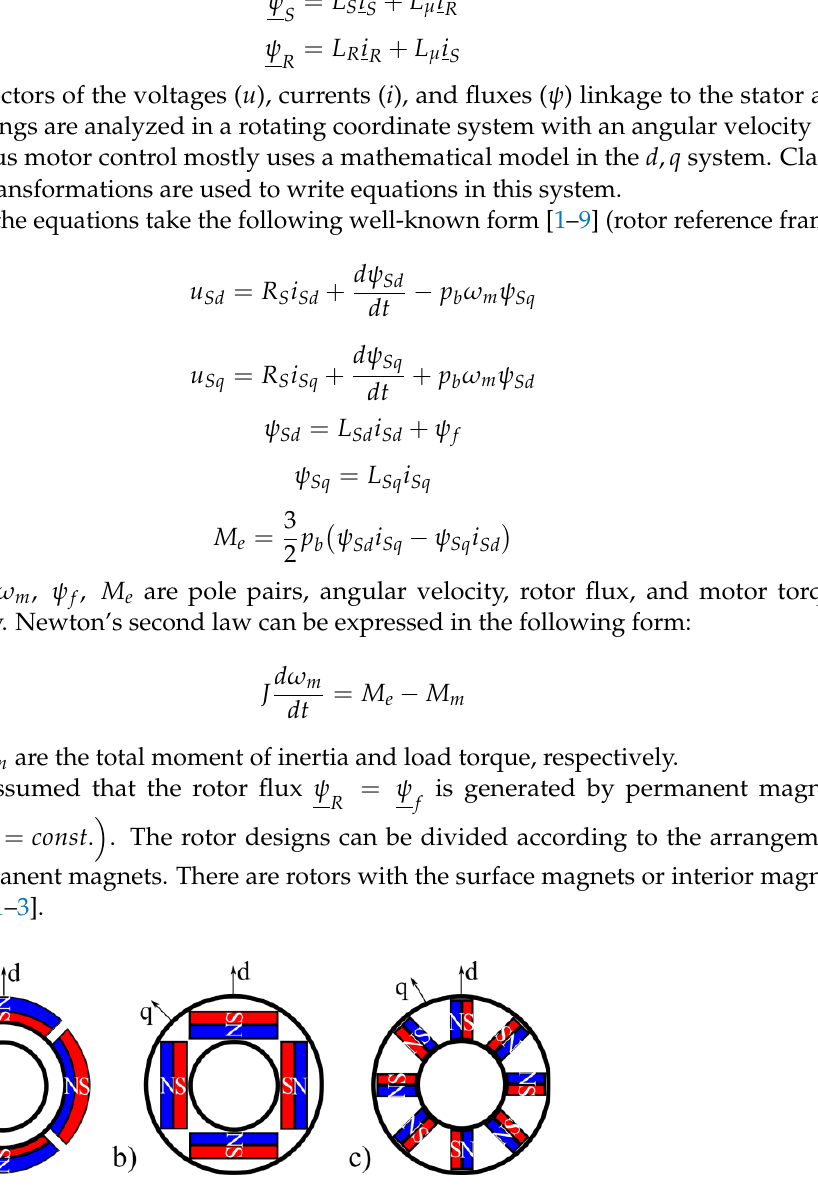
Figure 1. Design of PMSM rotors: ( a ) with surface magnets; ( b ) rotor with interior magnets, configuration 1; ( c ) rotor with interior magnets, configuration 2.